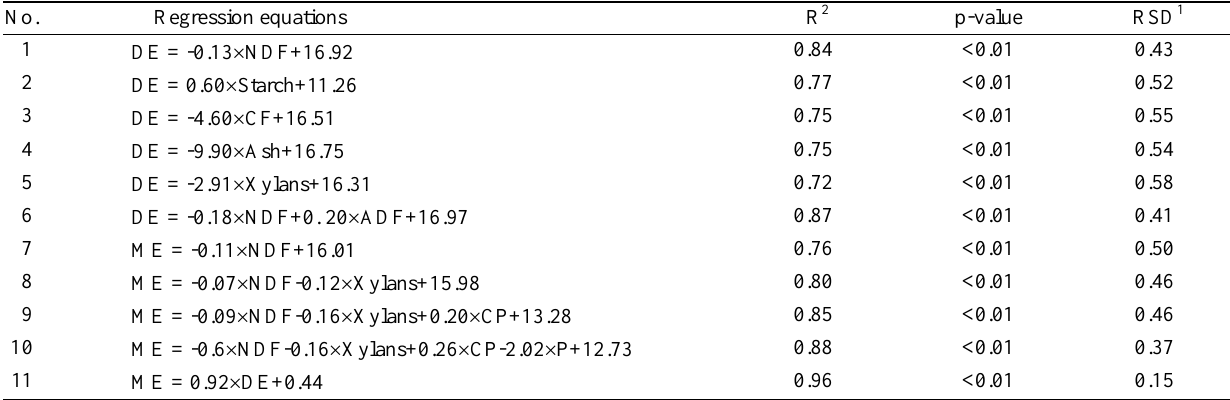
Table 5. Prediction of energy value (MJ/kg of DM) from chemical composition (% of DM) in wheat shorts and red dog